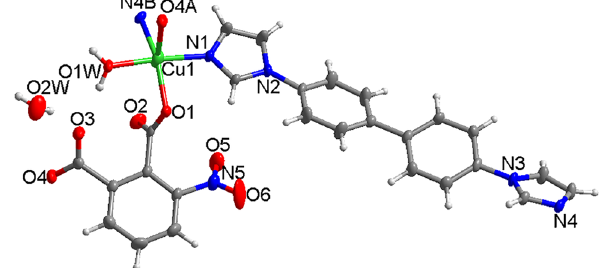
Table  : Data collection and